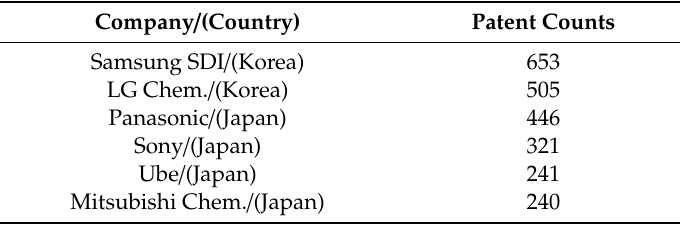
Table 1. Patent counts of top six patent